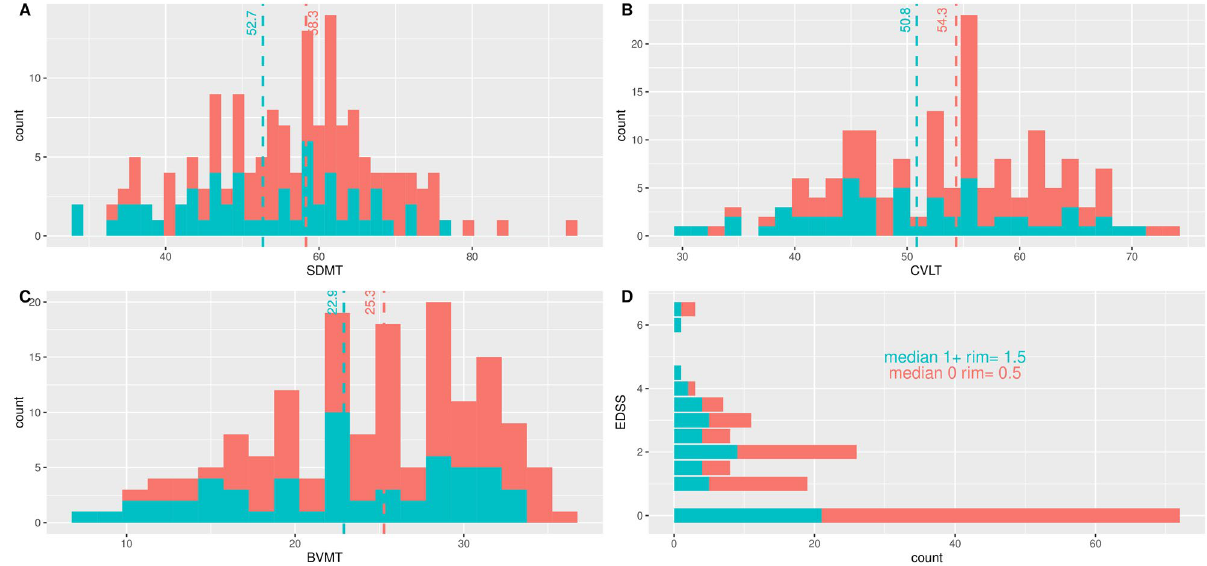
Figure 2. Distribution of disability scores comparing patients with zero (0: red) rim+ lesions versus patients with at least one rim+ lesion (1+: blue). Dash lines represent the mean for each group. Patients with at least one rim+ lesion performed worse on average SDMT ( A ), CVLT-II ( B ), BVMT-R ( C ) and EDSS ( D